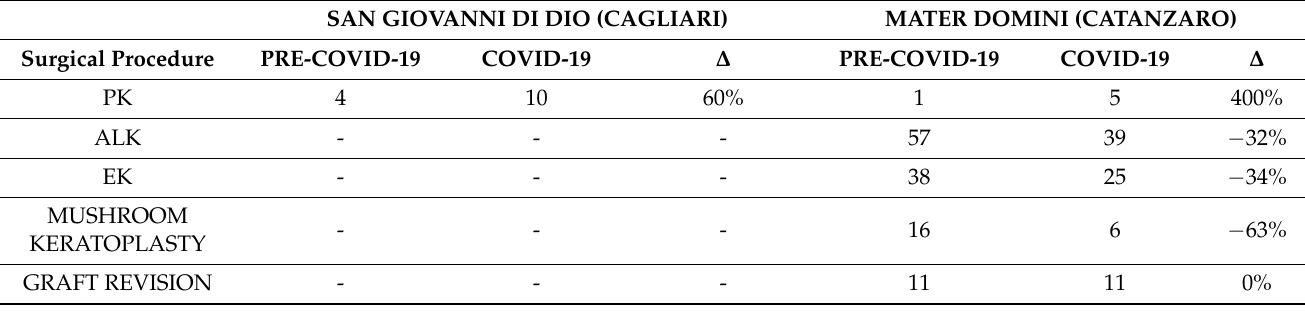
Table 3. Comparison of different types of anterior segment surgical procedures at San Giovanni di Dio (SGD), University of Cagliari, and Mater Domini, University Magna Græcia of Catanzaro